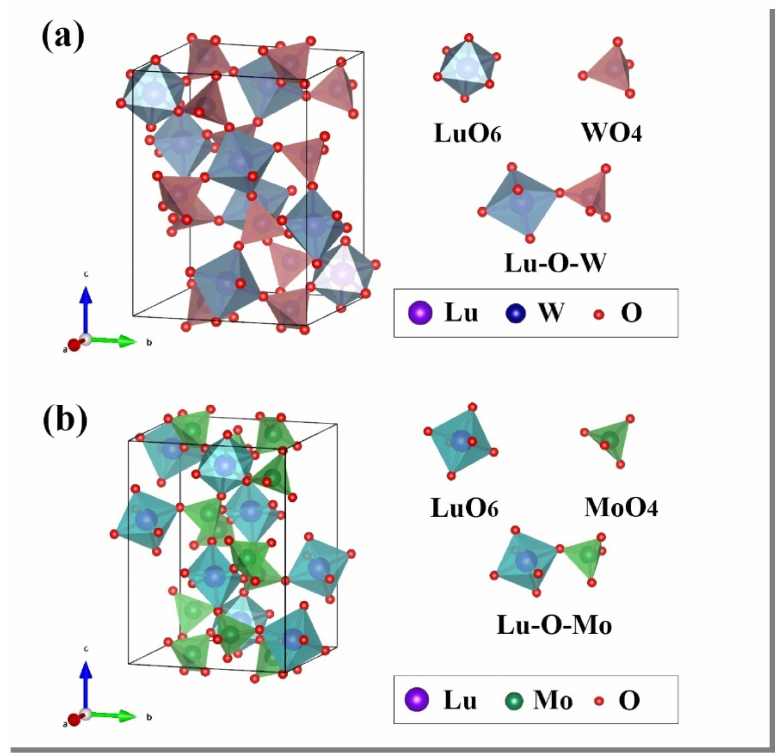
Figure 4. Schematic crystal structure diagrams of Lu 2 W 3 O 12 ( a ) and Lu 2 Mo 3 O 12 ( b